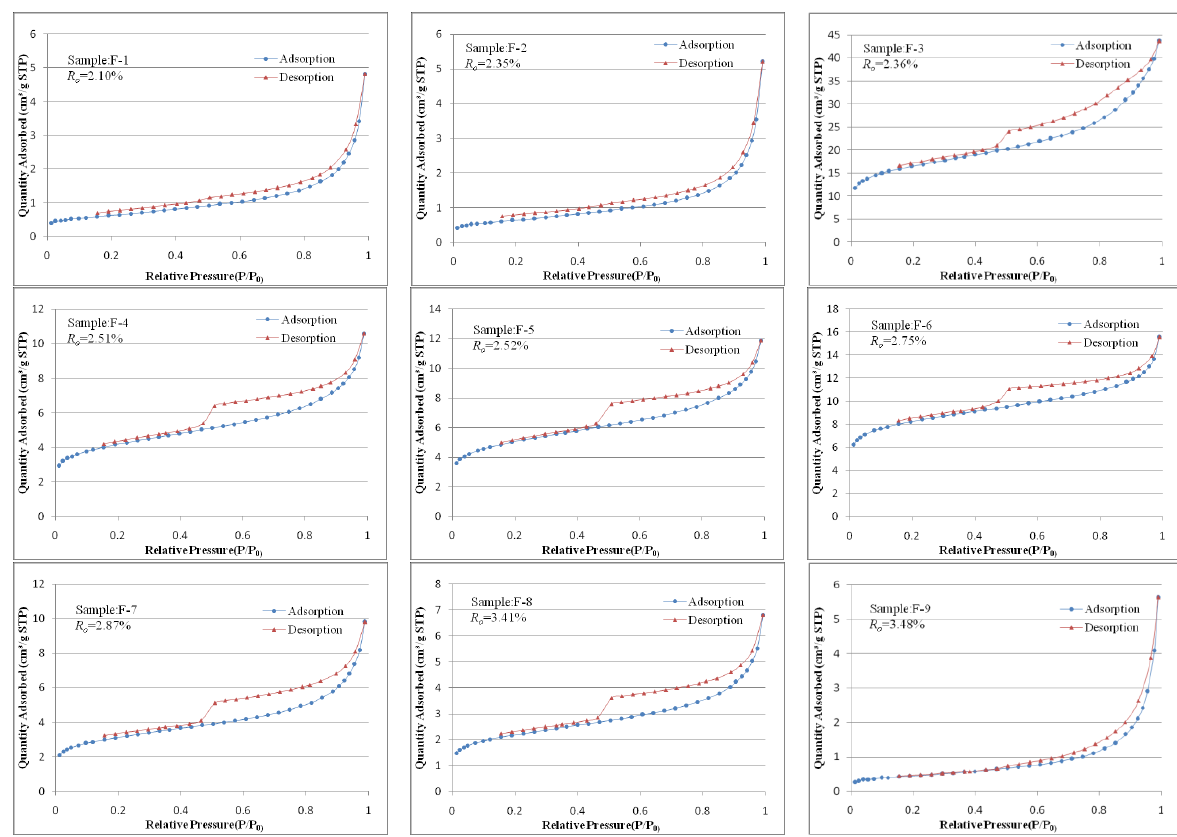
Figure 3: Low-temperature liquid nitrogen adsorption results of organic-rich shale. Table 2: FHH model to calculate shale pore fractal dimension.